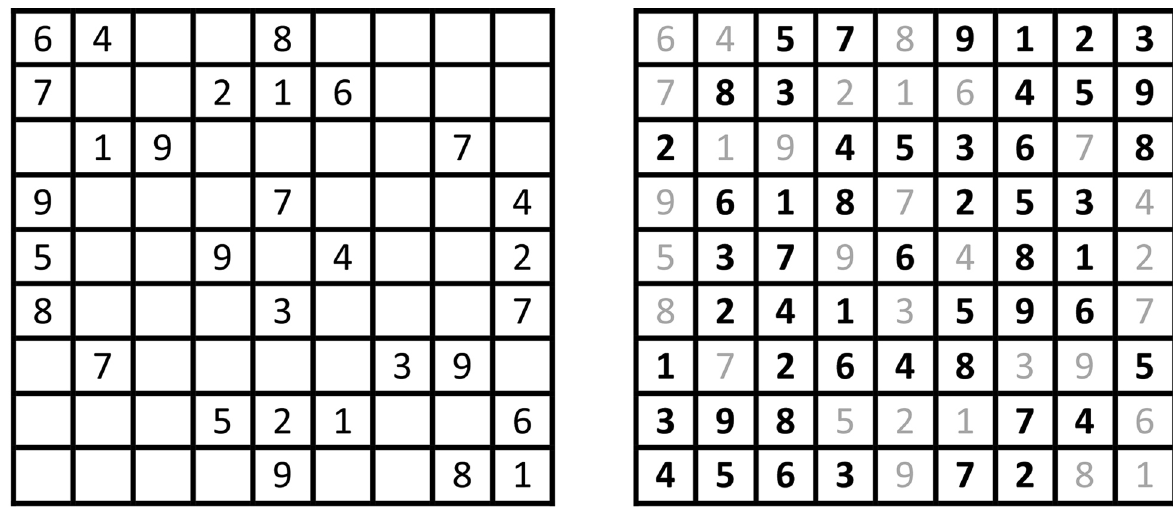
Fig. 1. A Sudoku puzzle layout on the left with its solution on the